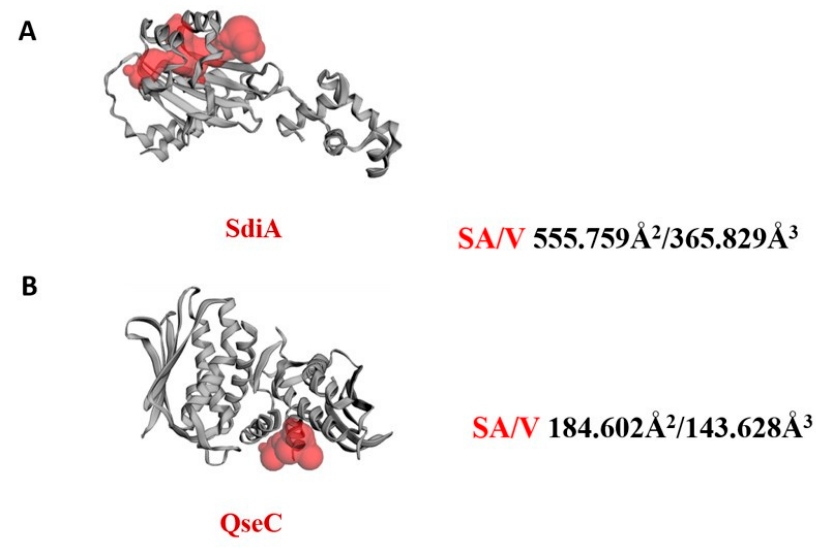
Figure 6. Cartoon representation of the binding site topology at the bacterial targets ( A ) SdiA, ( B ) QseC. Putative pockets; red color, were calculated via the on-line Computed Atlas of Surface Topography of proteins (CASTp; http://sts.bioe.uic.edu/castp/index.html, accessed on 10 June 2022).